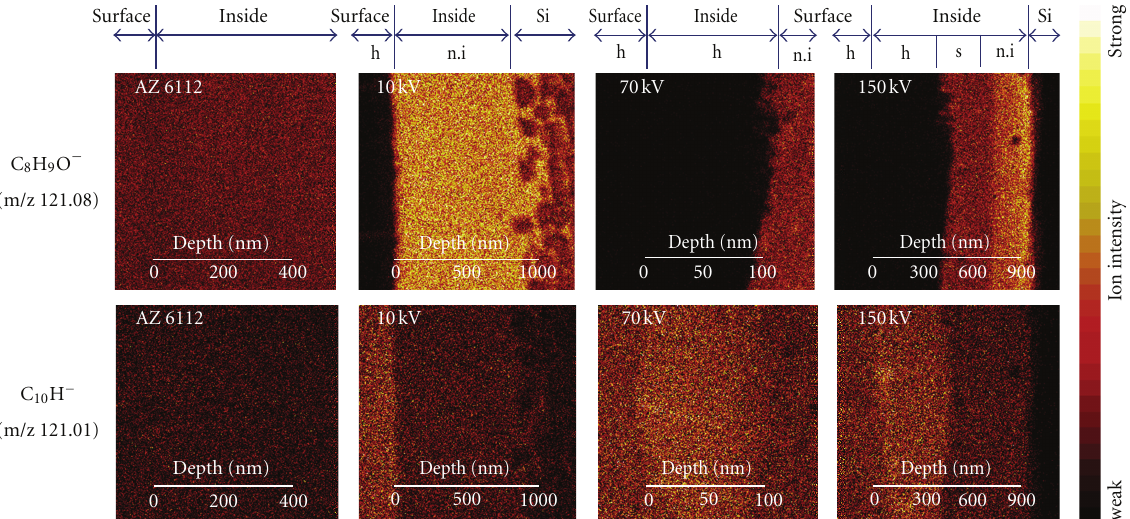
Figure 8: Secondary negative ion images of ion-implanted resists with various acceleration energies (h: hardened layer, n.i.: nonimplanted. s: stripped